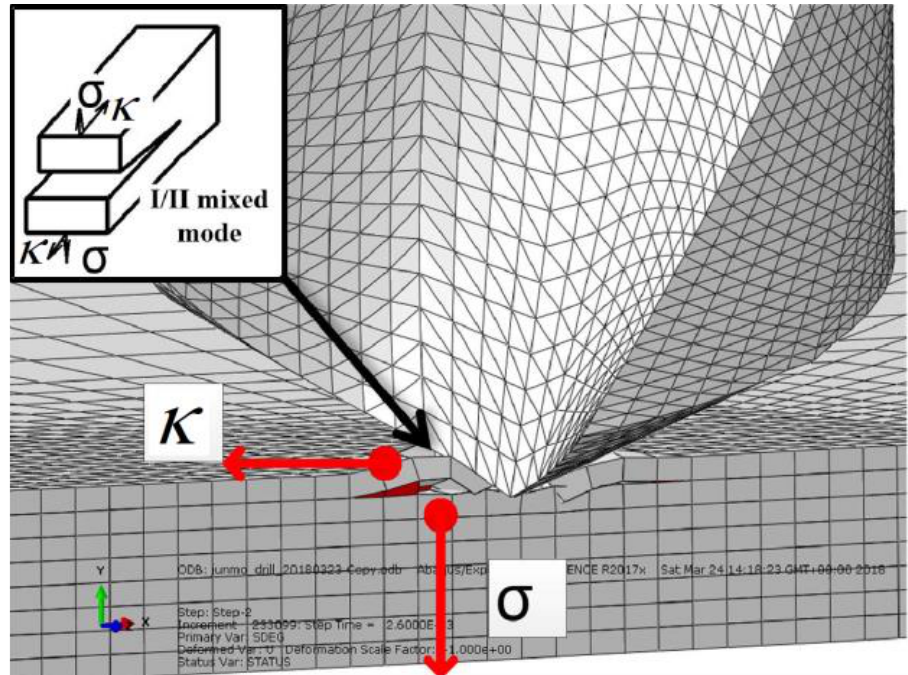
Figure 5. Crack form of drill entry chisel edge.